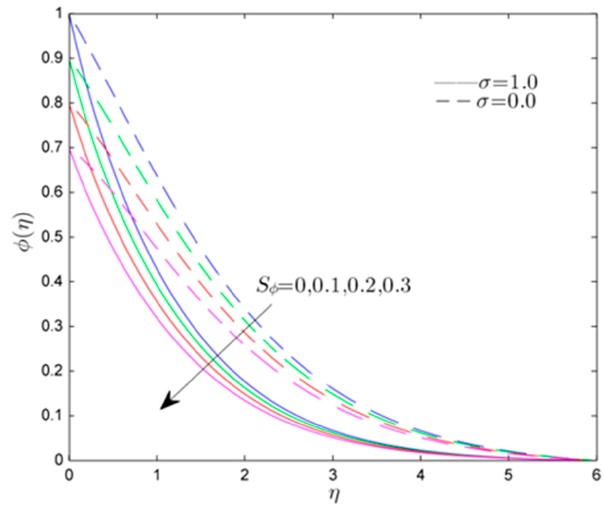
(cid:0) (cid:1) S φ on φ ( η )